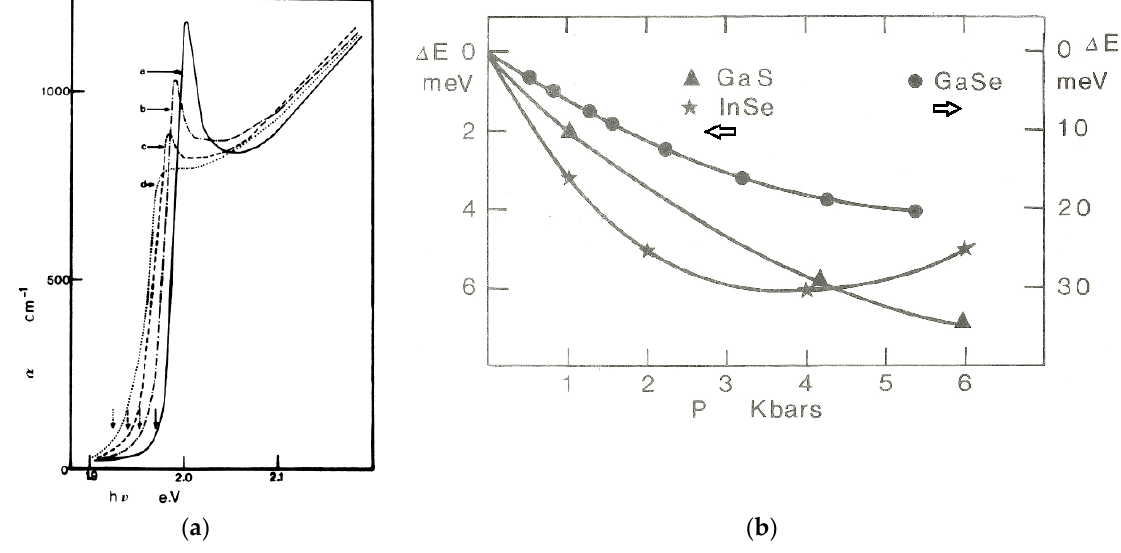
Figure 5. Pressure dependence of the direct absorption edge in III–VI semiconductors. ( a ) Absorption edge of GaSe at different pressures [48]. ( b ) Pressure dependence of the direct gap shift for GaSe [48], InSe [49], and GaS [47].